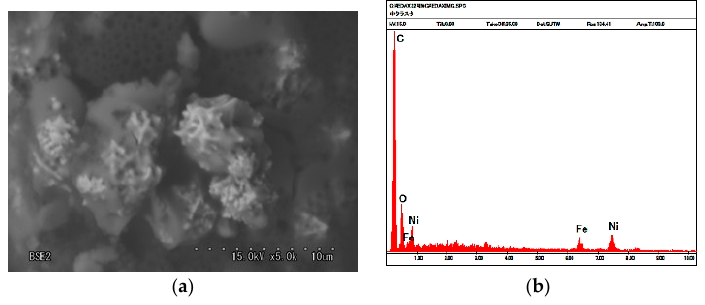
Figure 9. ( a ) SEM photograph (5000× magnification of 5000) of microspores of magnetic clusters inside solidified MCF rubber; ( b ) XRD mapping of ( a ).